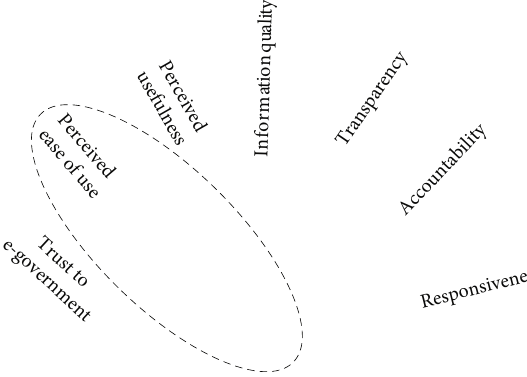
Figure 4: Path 1 contributes to high e-government participation (HEP) ( consistency = 0 : 980 and coverage = 0 : 824 ). Note: the solid ellipse represents the presence of the condition. If no ellipse is displayed, it belongs to the “ do not care ” condition.